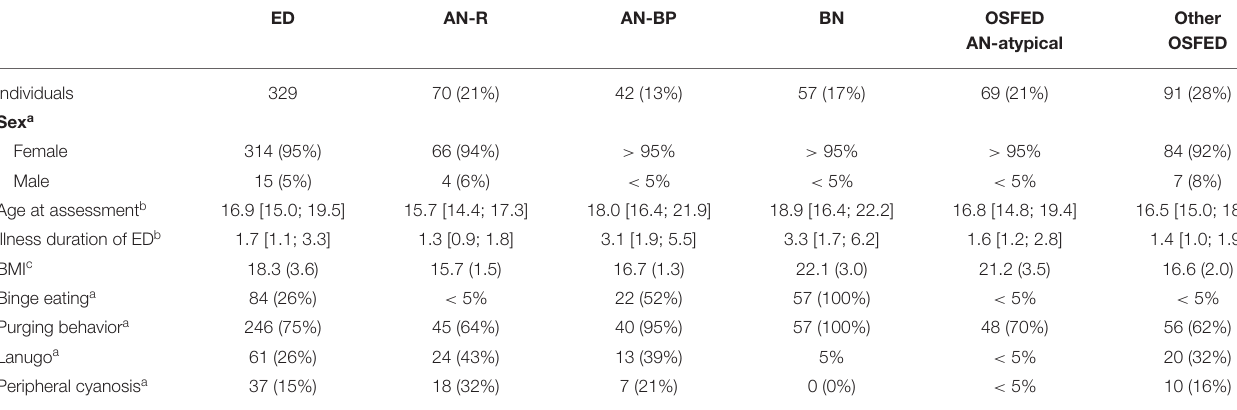
TABLE 1 | Characteristics of the study population. ED